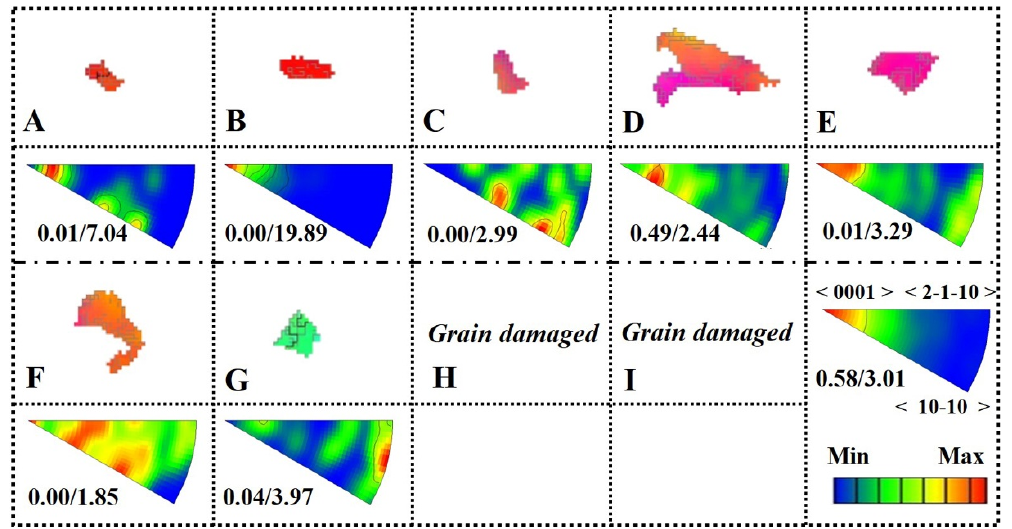
Figure 8. Selected grain A–I from Figure 5a, and the corresponding IGMA distribution below the selected grains map are used to determine the activated slip modes; the overall IGMA distribution of Figure 5b is shown in the bottom right corner. The maximum and minimum intensities of IGMA distribution are also given on the bottom of each IGMA distribution. Table 3. Calculated SF N values for slip modes of selected grains in TD